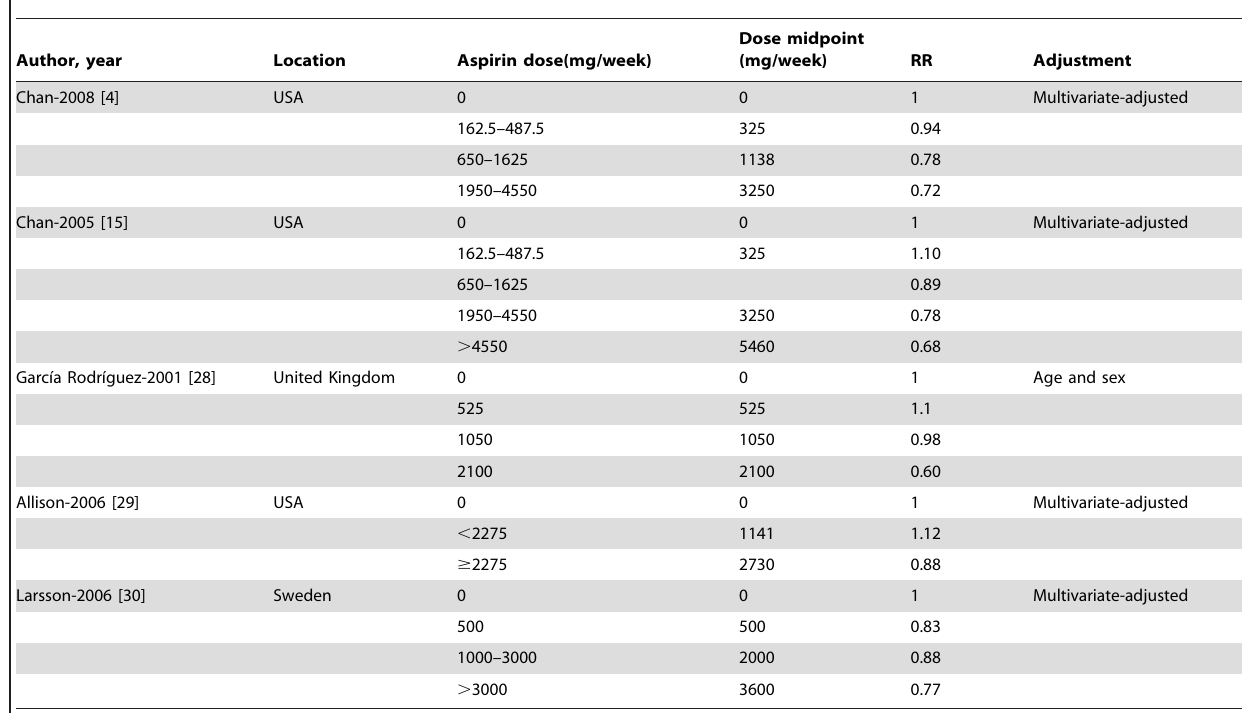
Table 1. Epidemiological studies of aspirin dose (mg/week) and colorectal cancer.